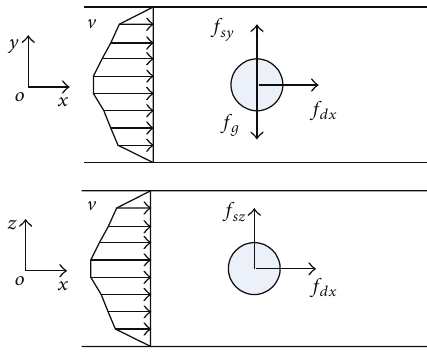
Figure 1: Forces and motion of particle in horizontal uniform